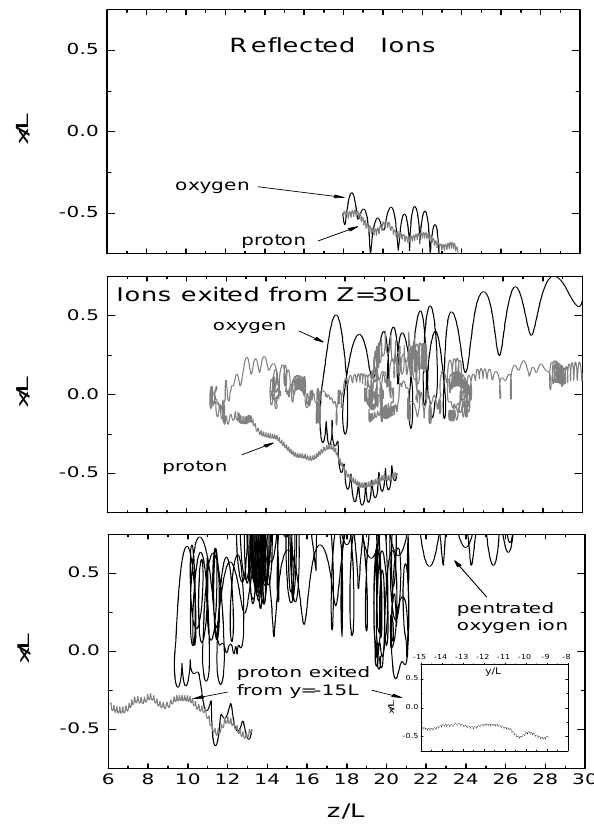
Fig. 2. Sample trajectories of proton and oxygen ions in the sim- ulation box, for δB/B 0 = 0 . 6. All the particles are injected at x =− 0 . 5 L . Black lines: oxygen. Grey lines: protons. Upper panel: particles exiting from the injection side (“reflected”). Middle panel: particles exiting from the side boundaries. Lower panel: oxygen ex- iting from the magnetosheath side, proton from the side